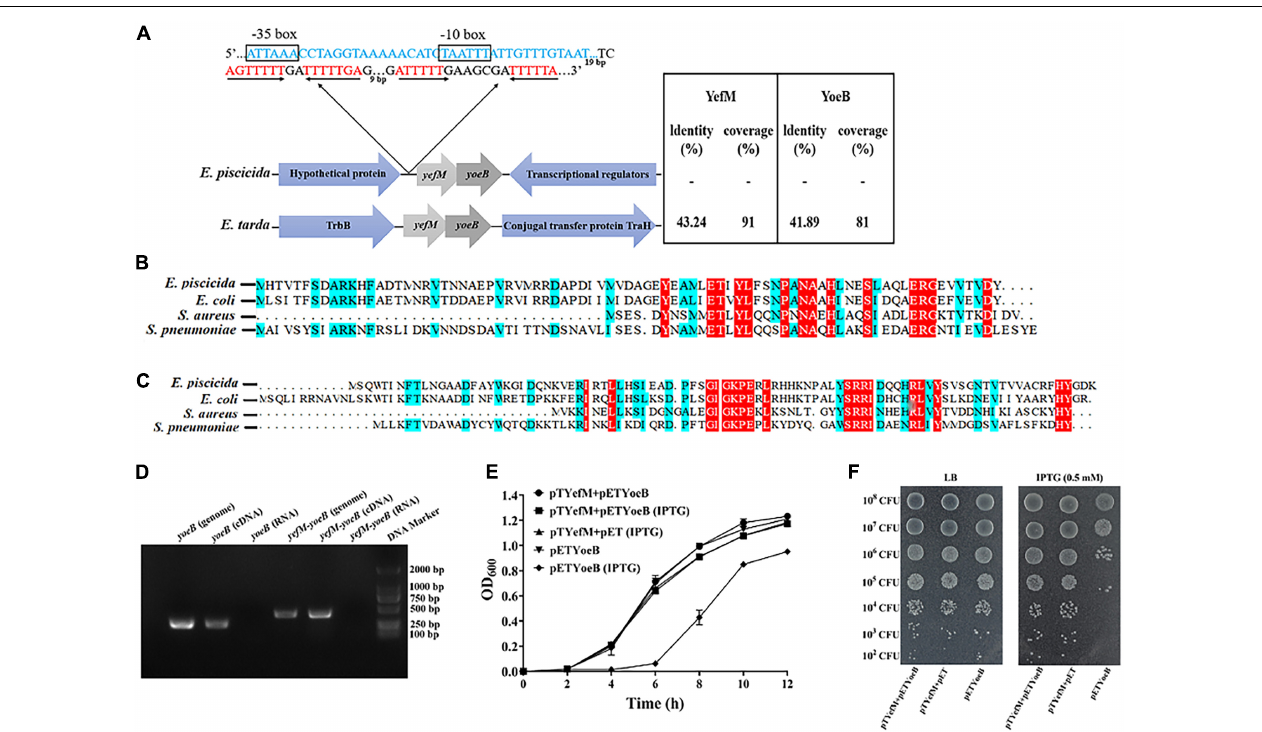
FIGURE 1 | Identification of type II TA system YefM/YeoB in Edwardsiella piscicida . (A) Genetic organization of YefM/YeoB operon in Edwardsiella . The amino acid sequences of E. piscicida YefM and YeoB were searched against Edwardsiella (taxid:635) database and two bacterial strains of Edwardsiella found in the protein BLAST search. Arrows represent genes and genetic context, sizes and spaces are only for representation and are not at actual scale. In the 5 (cid:48) -UTR of yefM-yoeB , a promoter region (blue sequence) we predicted and –10 and –35 region were boxed. Two mirror repeat sequences (red sequence) were found in downstream of predicted promoter region. (B,C) Sequence alignment of YefM and YoeB from E. piscicida Escherichia coil , Staphylococcus aureus , and Streptococcus pneumoniae , respectively. (D) Identification of yefM and yeoB co-transcription. Total RNA was isolated from E. piscicida at a turbidity of 0.8 at 600 nm and treated with DNase I. cDNA was synthesized and used as the template in PCR. PCR products were amplified with specific primer pair YoeBRTF/YoeBRTR for yoeB and with primer YefM-YeoBRTF and specific reverse primer YefM-YeoBRTR for yefM-yeoB . Genomic DNA was used as a positive control, and total RNA was used as a negative control. (E) Inhibition of cell growth by YeoB. Stains BL21/pETYeoB, BL21/pTYefM+Pet, and BL21/pTYefM+pETYeoB were cultured in LB medium with or without IPTG (0.5 mM). (F) BL21/pETYeoB, BL21/pTYefM+pET, and BL21/pTYefM+pETYeoB were cultured to the exponential phase, diluted serially and dripped onto the LB plate with or without 0.5 mM IPTG. Data are presented as means ± SEM ( N = 3). N, the number of times the experiment was